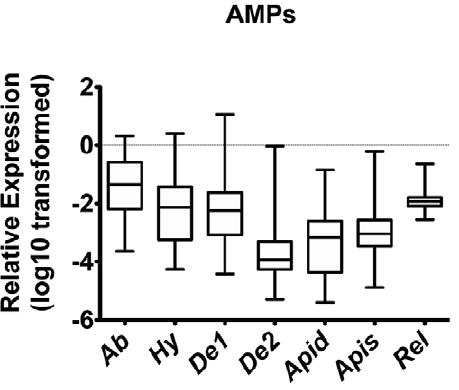
Figure 1. Broad range of AMP production in midgut barrier epithelium. Individual levels of the six honey bee AMPs ( Abaecin (n=91), Hymenoptaecin (n=91), Defensin 1 (n=92) , Defensin 2 (n=91), Apidaecin ( n=92) , and Apisimin ( n=92) ) and the immune signaling protein Relish ( n=91) relative to b -actin in midgut tissue from both nurses and foragers from multiple hives. Boxes show 1st and 3rd interquartile range with line denoting medians. Whiskers encompass 95% of the individuals. Outliers are denoted with filled